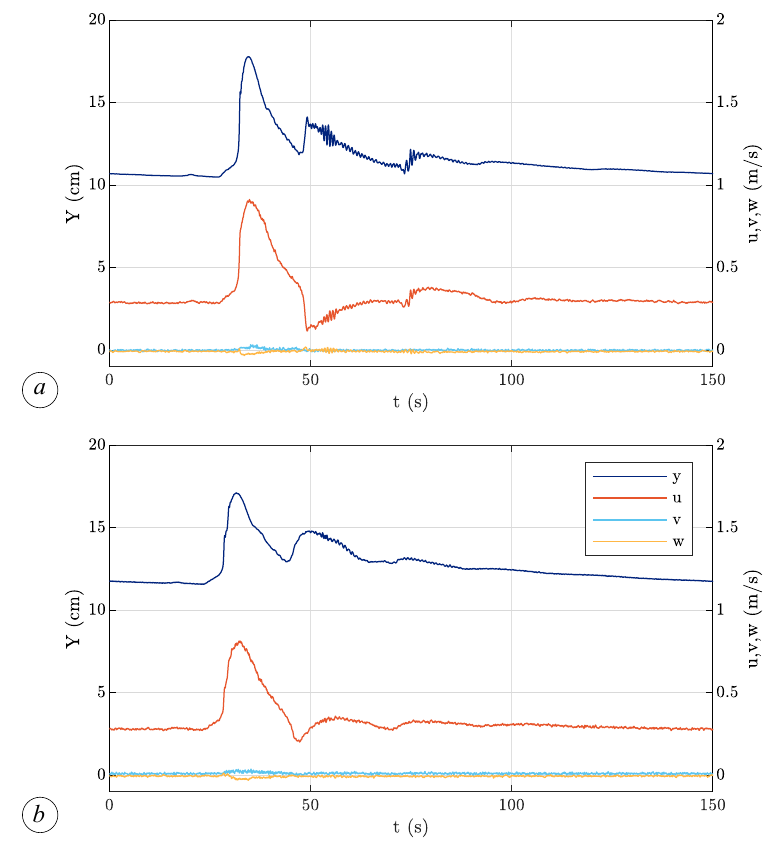
Figure 6. Water level ( Y ) and velocity components ( u , v , w ) measured at x = 10.5 m and z = 2 cm ( a ) without vegetation and ( b ) in the presence of vegetation with density n = 156.25 cylinder/m 2